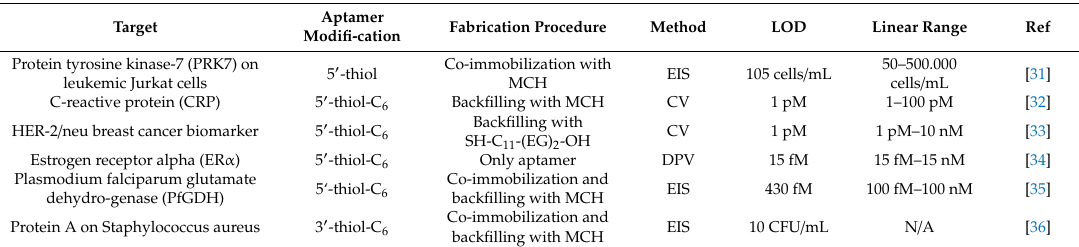
Table 1. Aptasensors that were fabricated by co-immobilization / backfilling of thiolated aptamers with